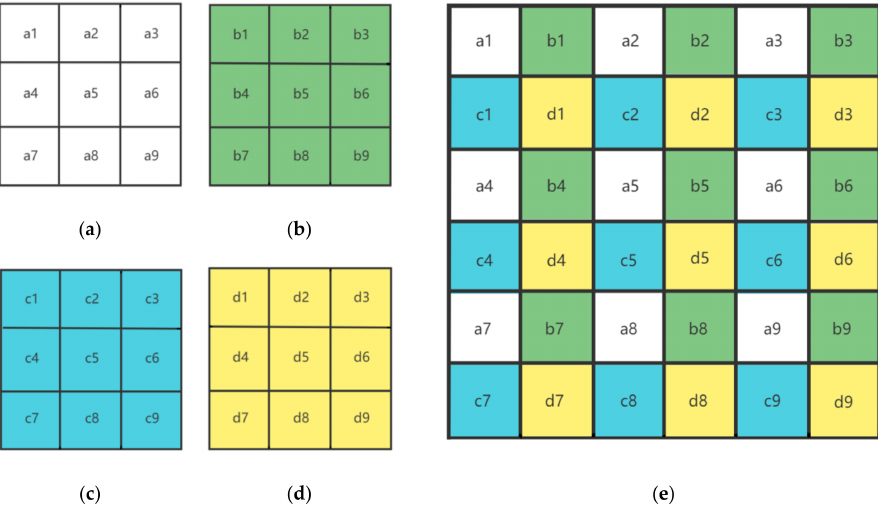
Figure 6. How high-resolution images are created by combining the pixels of individual native- resolution images. ( a – d ) are four acquired original images, and ( e ) is 2 × 2 mode higher-resolution